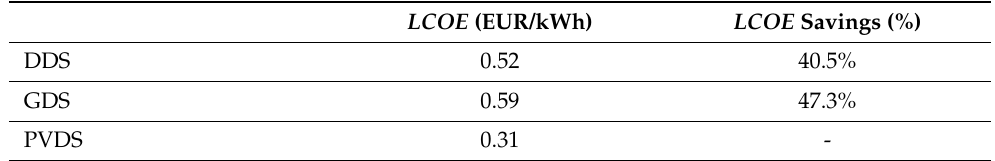
Table 6. Levelized cost of energy ( LCOE ) of the diesel-powered drying system (DDS), the grid- powered drying system (GDS), and the PV-powered drying system (PVDS), and savings of the PVDS system compared to the DDS and